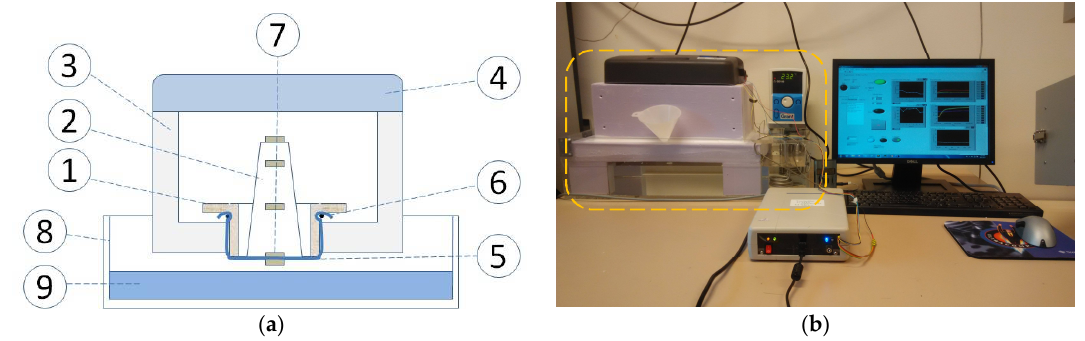
Figure 1. Schematic representation of main functional elements of the temperature stabilizing box with its content in a water bath ( a ), and view of the full setup for studying the dynamics of moisture transport through the fabrics ( b ). Outlined-temperature stabilizing box in a water bath with temperature